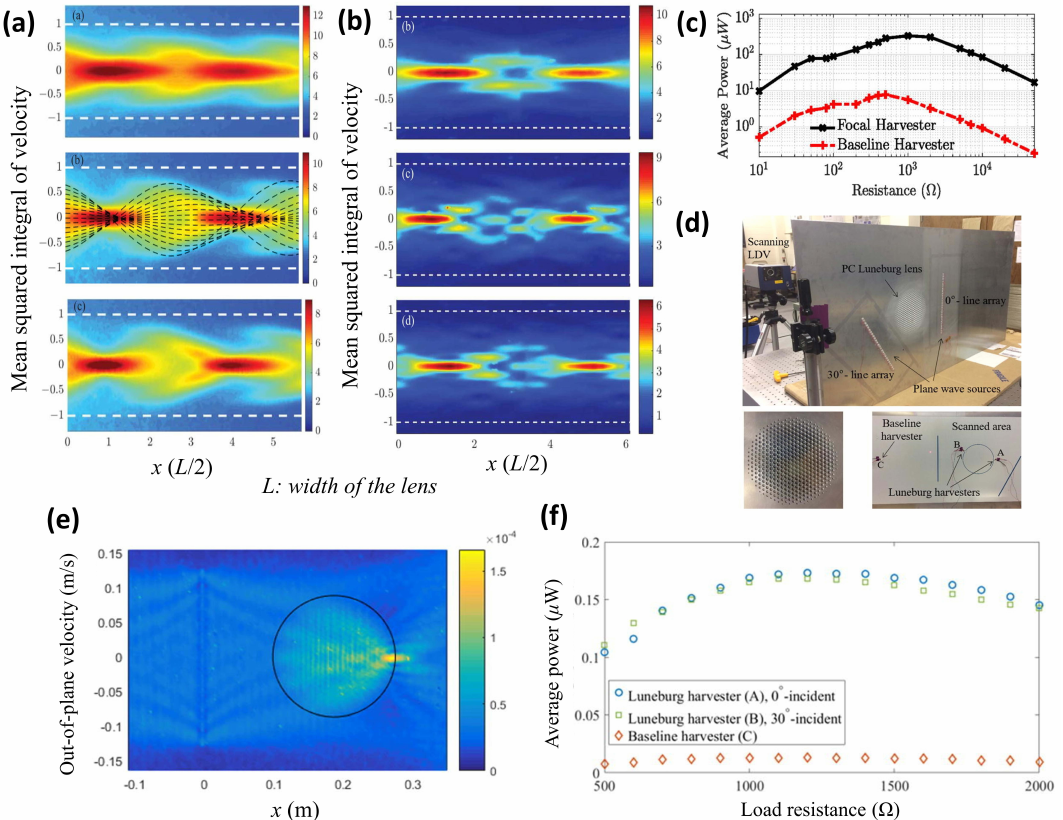
Figure 4. ( a ) Non-dimensionalized mean-squared integral of velocity generated by line source excitation for 20 kHz (top), 40 kHz (center), and 60 kHz (bottom). The focal points match the ray-theory simulation in the center figure; ( b ) Corresponding experiment results using a 100-k Ω resistor at (top) 20 kHz, (center) 40 kHz, and (bottom) 60 kHz. Dashed white line: outer edges of the lens; ( c ) Average power generated by the GRIN lens of load resistance at 40 kHz; ( d ) (top) Experimental apparatus, (lower left) close-up view of the PC lens sample. (lower right) Locations of the Luneburg harvesters and the baseline harvester; ( e ) Experimental root mean square (RMS) wave fields for incidence of (top) 0 ◦ ; ( f ) Average power generated by the PC Luneburg harvesters and baseline harvester. ( a – c ) adapted from [83]. ( d – f ) adapted from